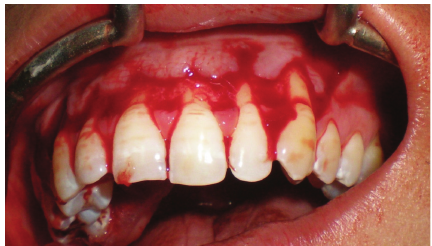
Figure 1: Pretreatment.